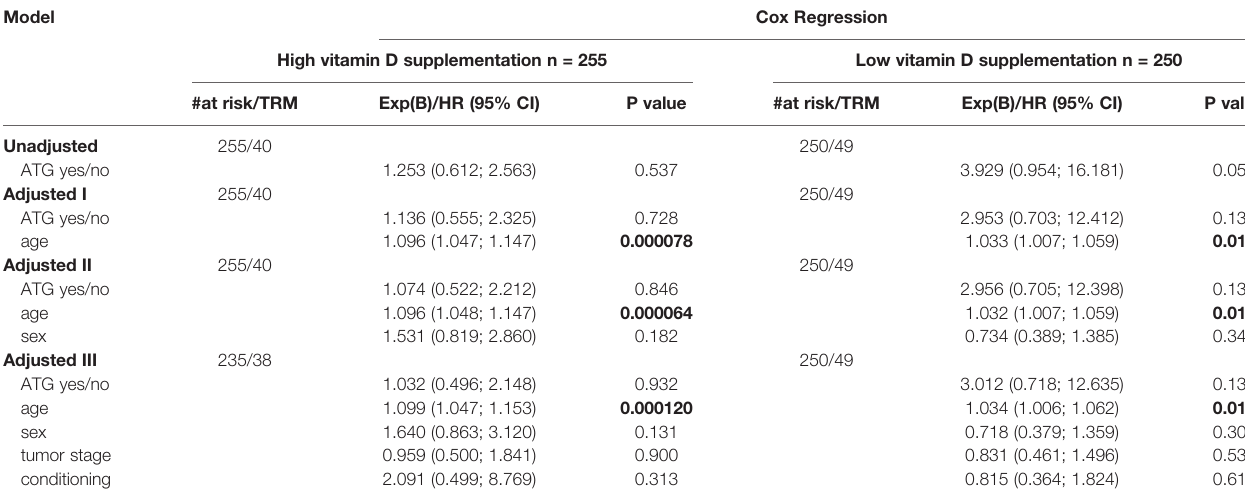
TABLE 1 | Association between ATG treatment, high/low vitamin D3 supplementation and TRM.